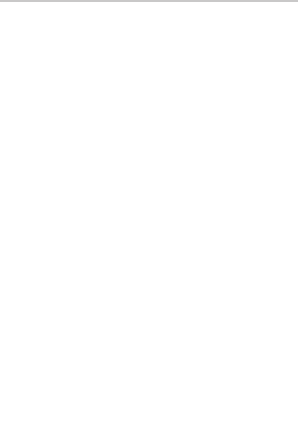
FIGURE 1 | Trend of crude mortality rates of diabetes in China 1987 –